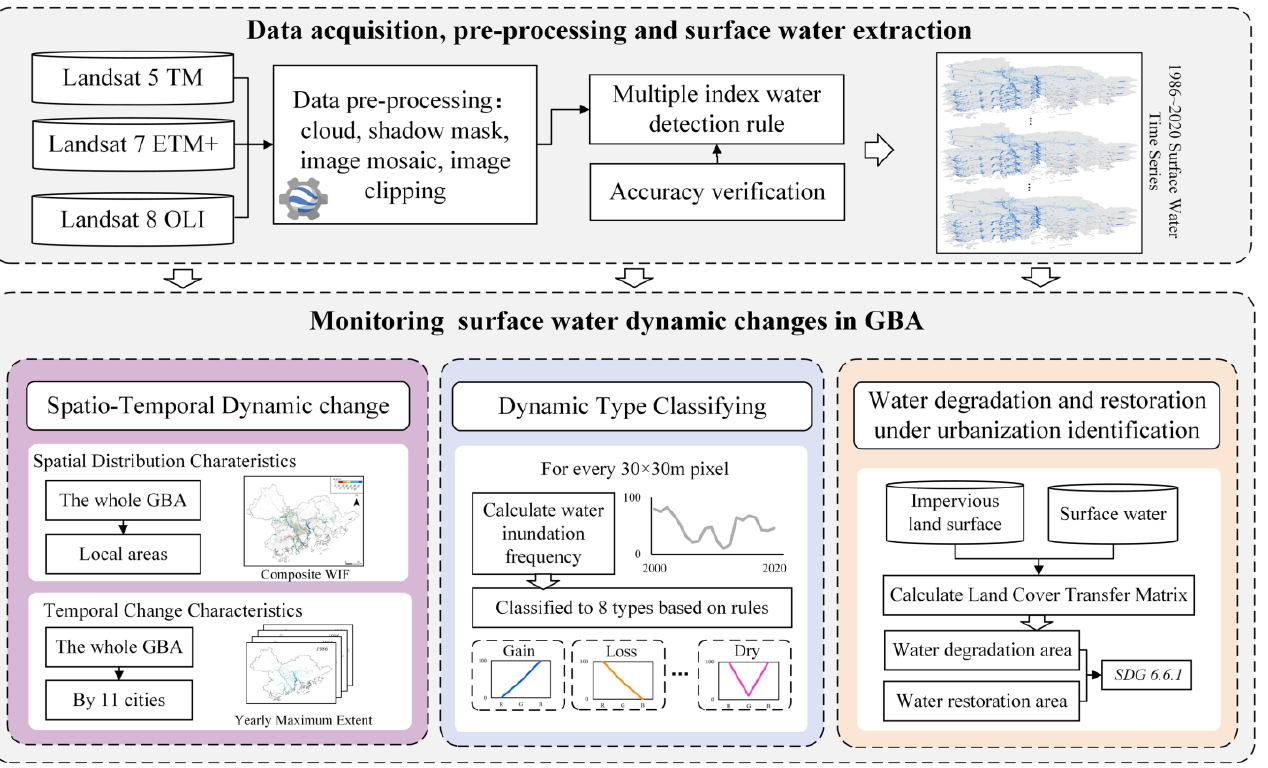
Figure 3. The framework of this study.